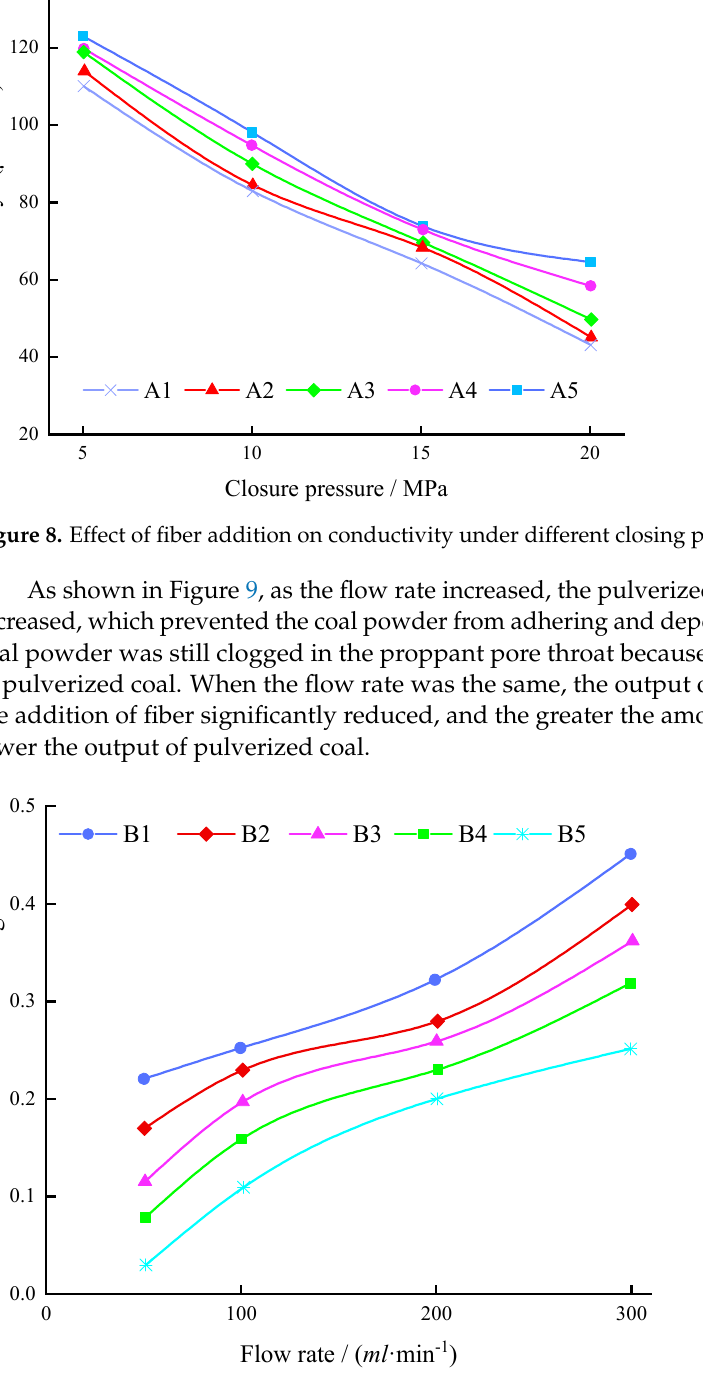
Figure 9. Effect of fiber addition on coal powder production under different flow rate conditions.